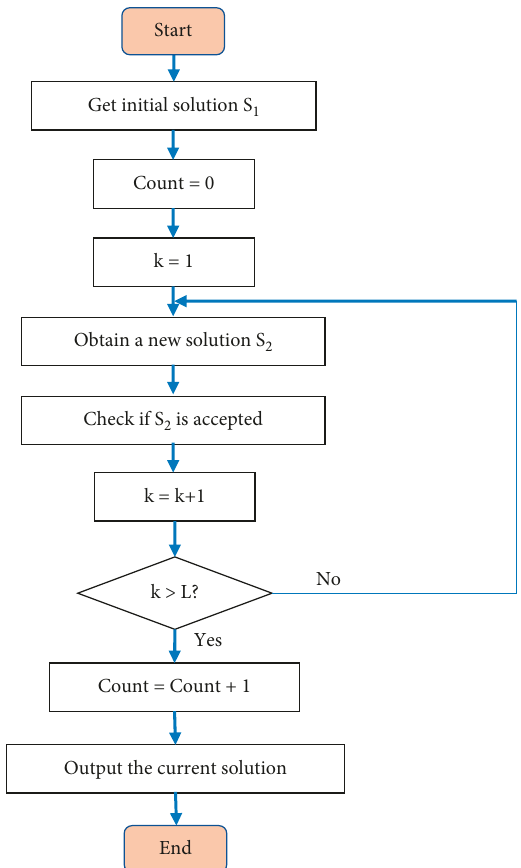
Figure 6: Steps of the simulated annealing